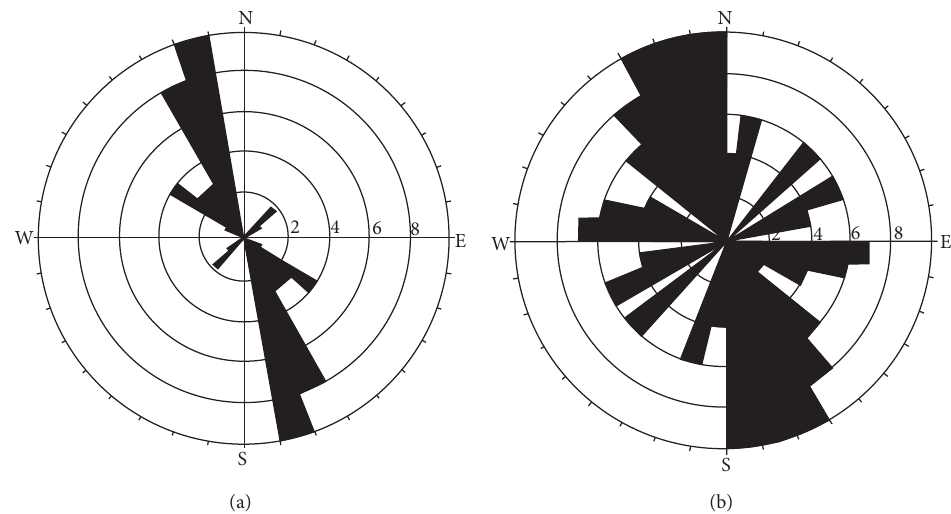
Figure 3: Direction of the maximum horizontal principal stress. (a) Measured in situ stress; (b) focal mechanism solution.